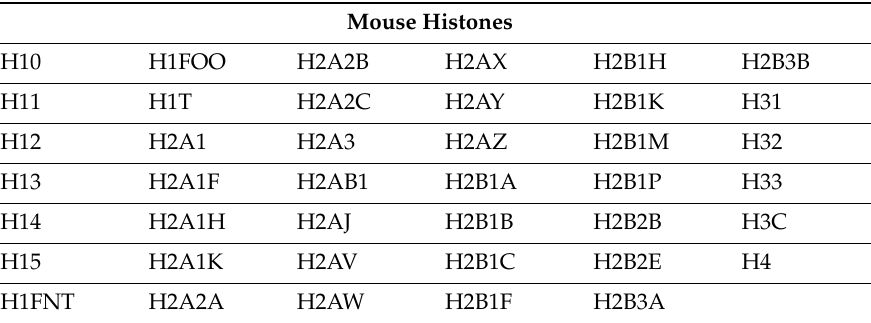
Table 2. List of mouse histones used for